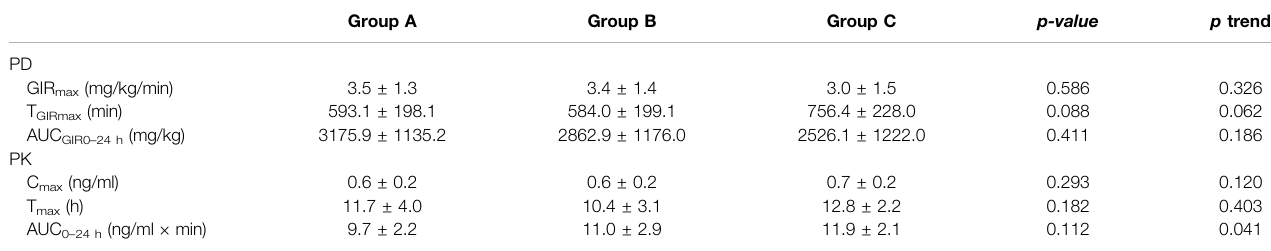
TABLE 3 | Pharmacokinetics (PK) and pharmacodynamics (PD) parameters in three groups.